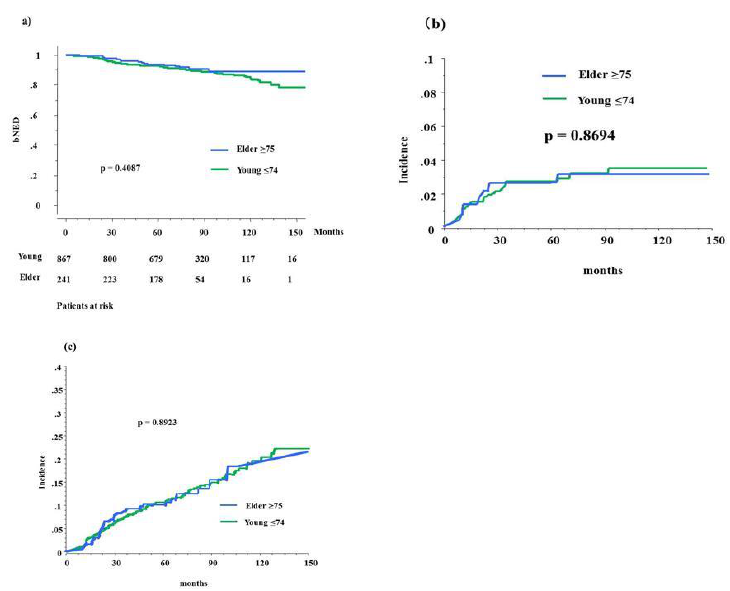
Figure 1. Biochemical control rates and accumulated incidence of toxicity between elder and younger counterparts. ( a ) Biochemical control rates between elderly ( ≥ 75) and control (young <75) in total population. ( b ) Accumulated incidence of gastrointestinal toxicity grade ≥ 2 between elderly and control in total population. ( c ) Accumulated incidence of genitourinary toxicity grade ≥ 2 between elderly and control in total population. bNED = no biochemical evidence of disease. Table 2. Univariate and multivariate analysis for biochemical control rate using Cox proportional hazards